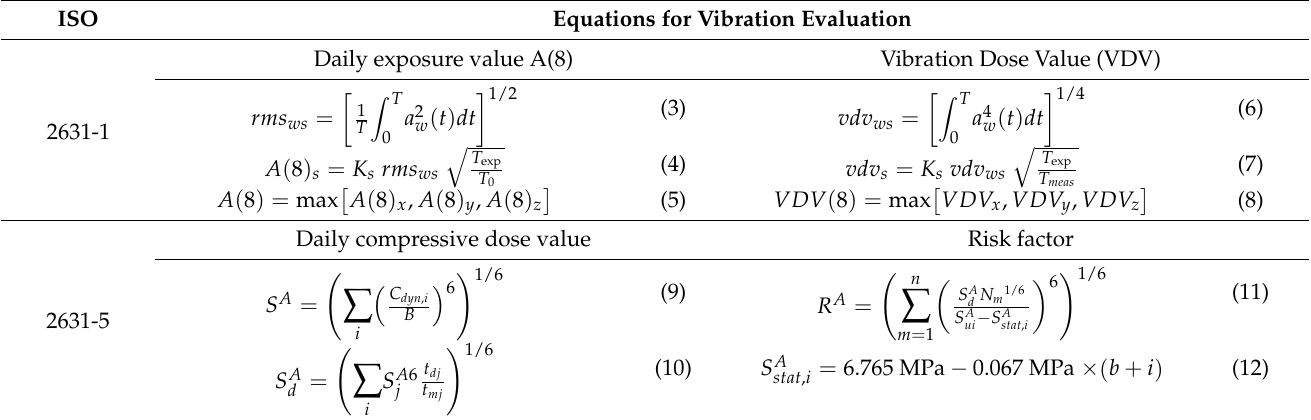
Table 4. ISOs for evaluating operator exposure to vibration, and their relevant equations. ISO Equations for Vibration